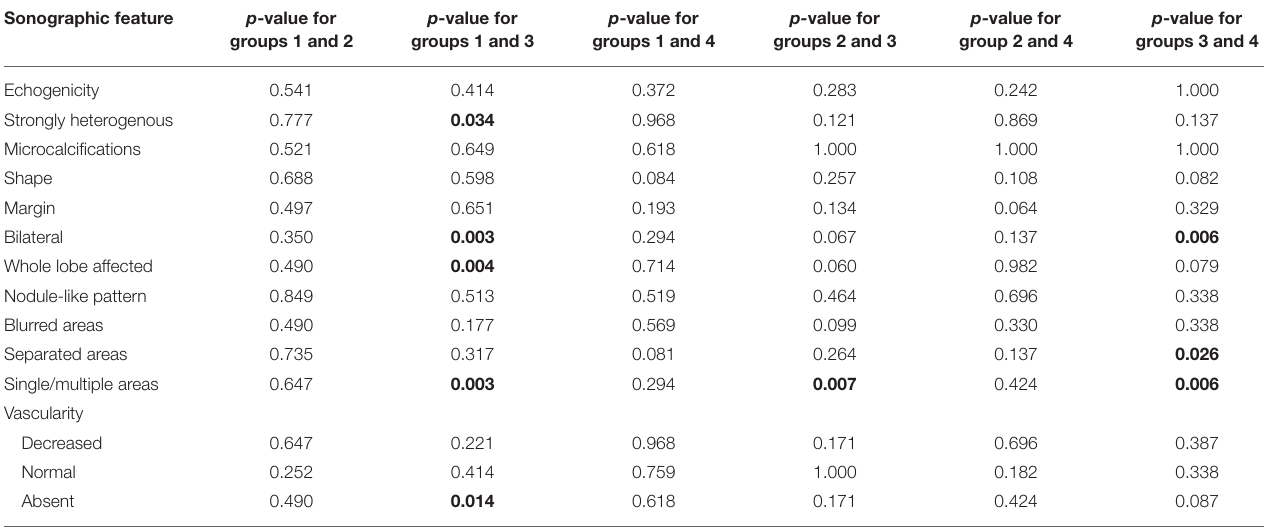
TABLE 2 | Comparison of sonographic features of the SAT lesions in pairs of the analyzed groups. p -value for p -value for Sonographic feature p -value for groups 1 and 2 groups 1 and 3 groups 1 and